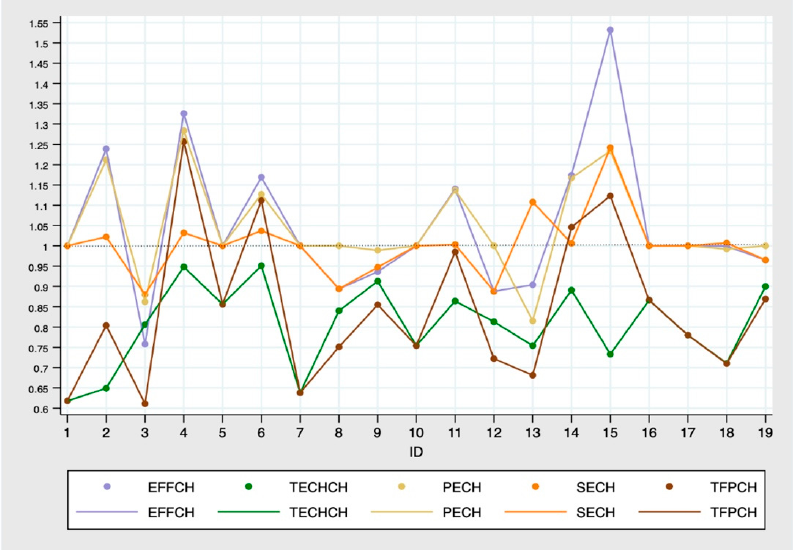
Figure 3. Malmquist index of wastewater treatment companies in 2017–2020.